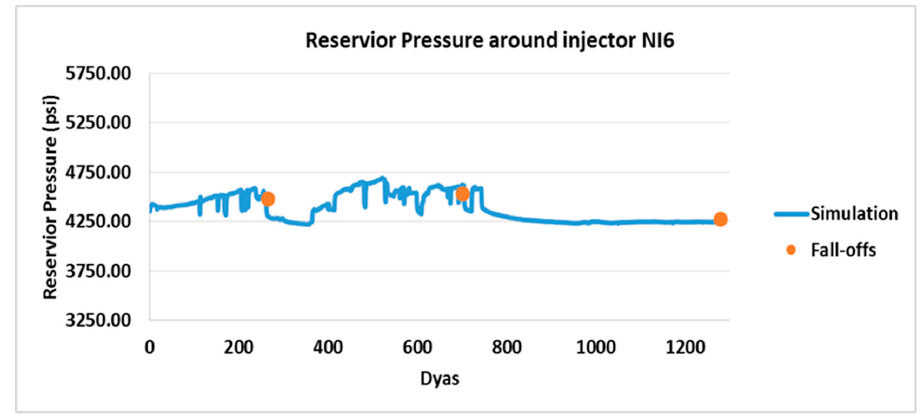
Figure 34. Matching simulated reservoir pressure to Fall-off test reservoir pressure around Well NI6.